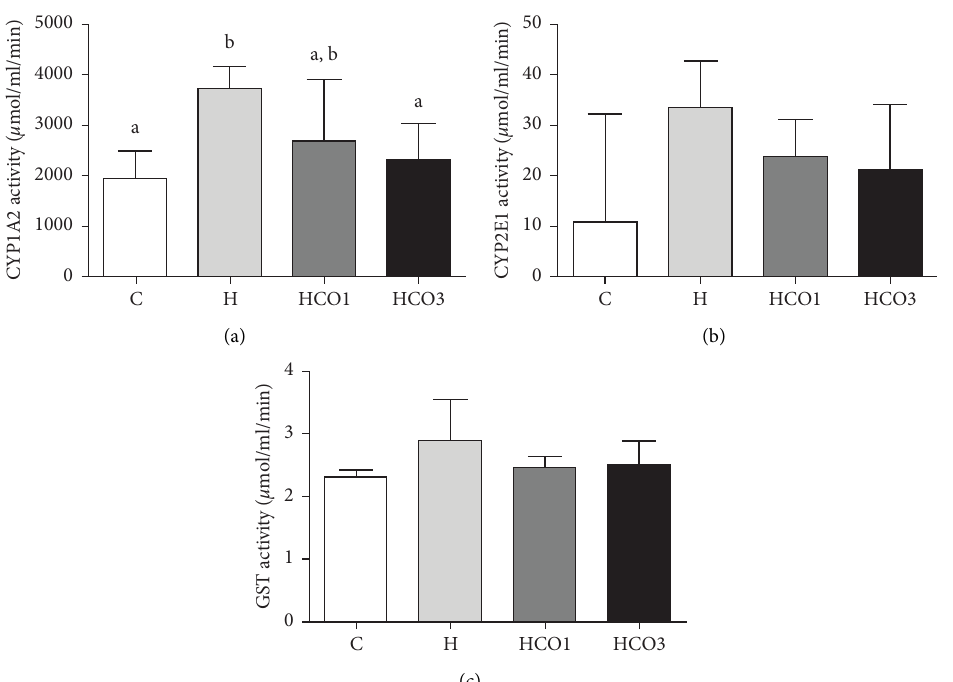
Figure 1: Plots of the enzyme activities of CYP1A2 (a), CYP2E1 (b), and GST (c) in the liver tissues of rats that were fed standard diet (C), HFD (H), and HFD with 1ml (HCO1) and 3ml (HCO3) per kg body weight of crocodile oil ( n � 7/group). Diferent letters in the same graph show statistically signifcant diferences between groups ( P < 0 .